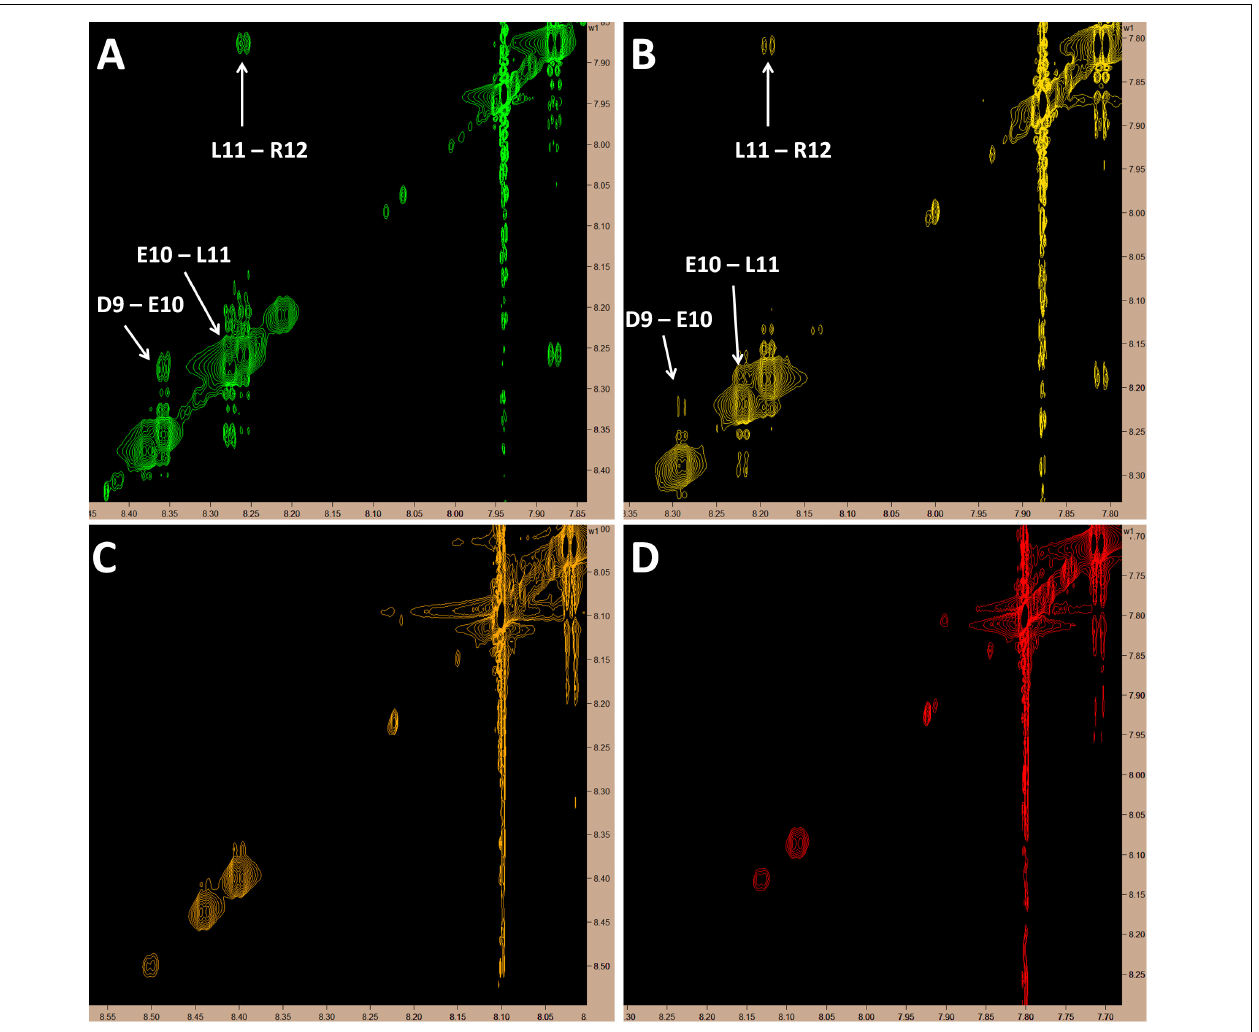
FIGURE 3 | Proton NMR showing amide to amide proximity. Cross-peak signals suggestive of a helical structure in the C-terminus of MTfp can be seen at 10 and 20 ◦ C but all signals in this region fade as temperature rises; possibly due to proton exchange with solvent. All images represent 5 mM MTfp in 25 mM sodium phosphate buffer at pH 7 with 5% D 2 O. (A) 10 ◦ C. (B) 20 ◦ C. (C) 30 ◦ C. (D) 37 ◦